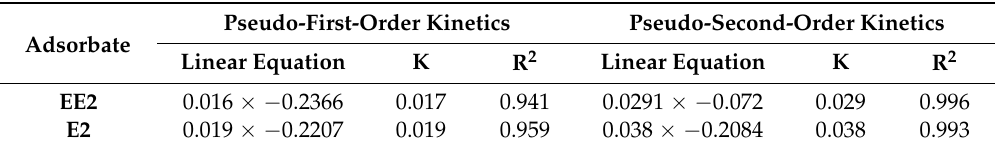
Table 2. Rate constants for the kinetic models.